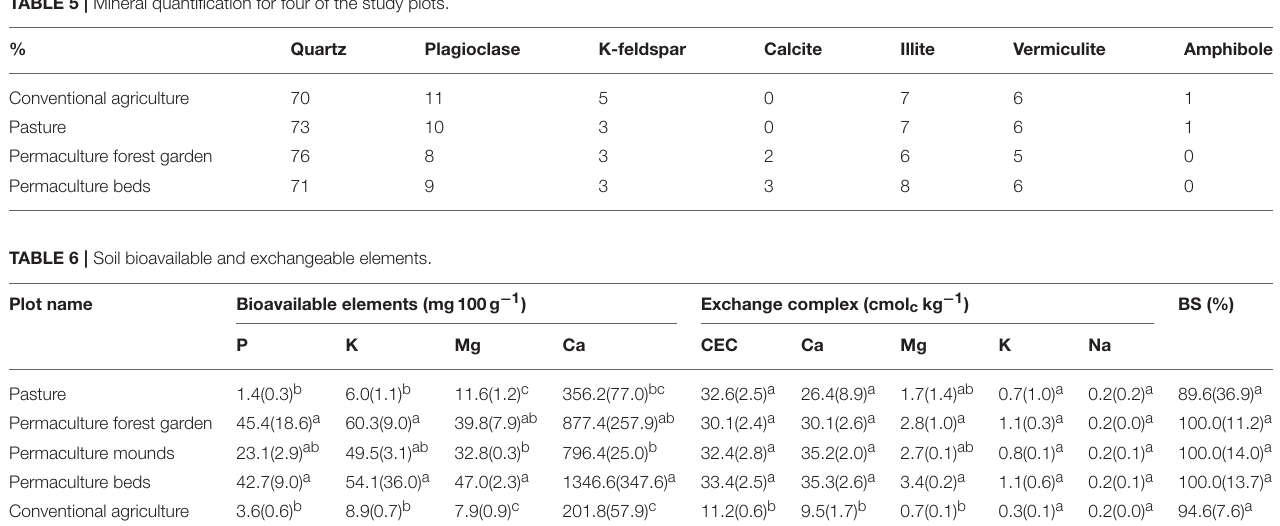
TABLE 5 | Mineral quantification for four of the study plots.